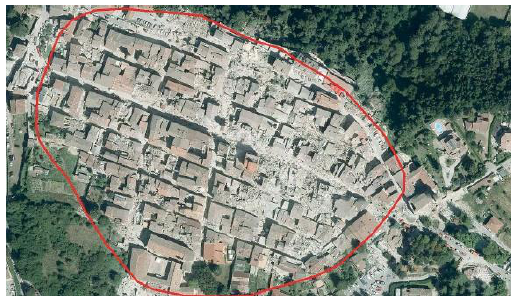
Figure 5: Amatrice post- earthquake